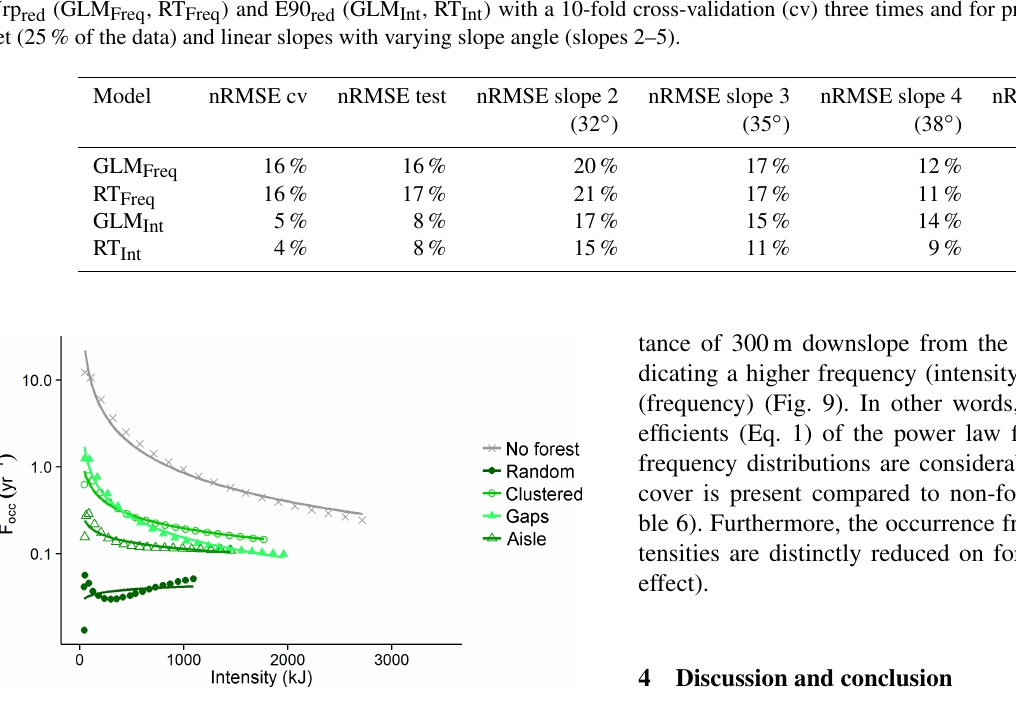
Figure 9. Frequency-intensity distributions with fitted power laws at a distance of 300m from the release area for forest type 1 (Ta- ble 2) with different horizontal forest structures and without